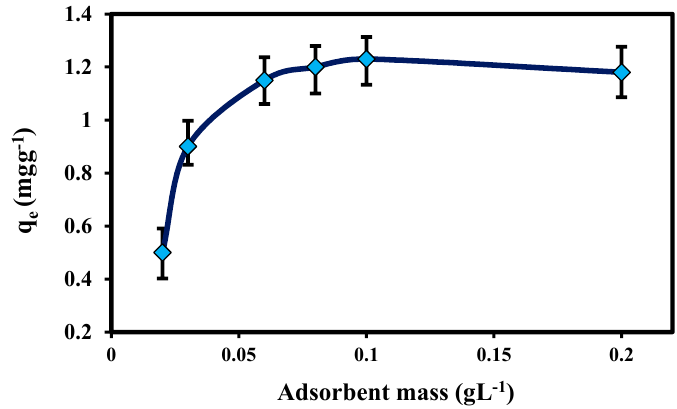
Figure 5. Effect of the mass of adsorbent on the Pb(II) adsorption onto ZnO-Nano-A: (solution volume, 25 mL; initial pH, 5.0; temperature, 30 °C; initial concentration, 10 mg L − 1 ; contact time, 1 h).